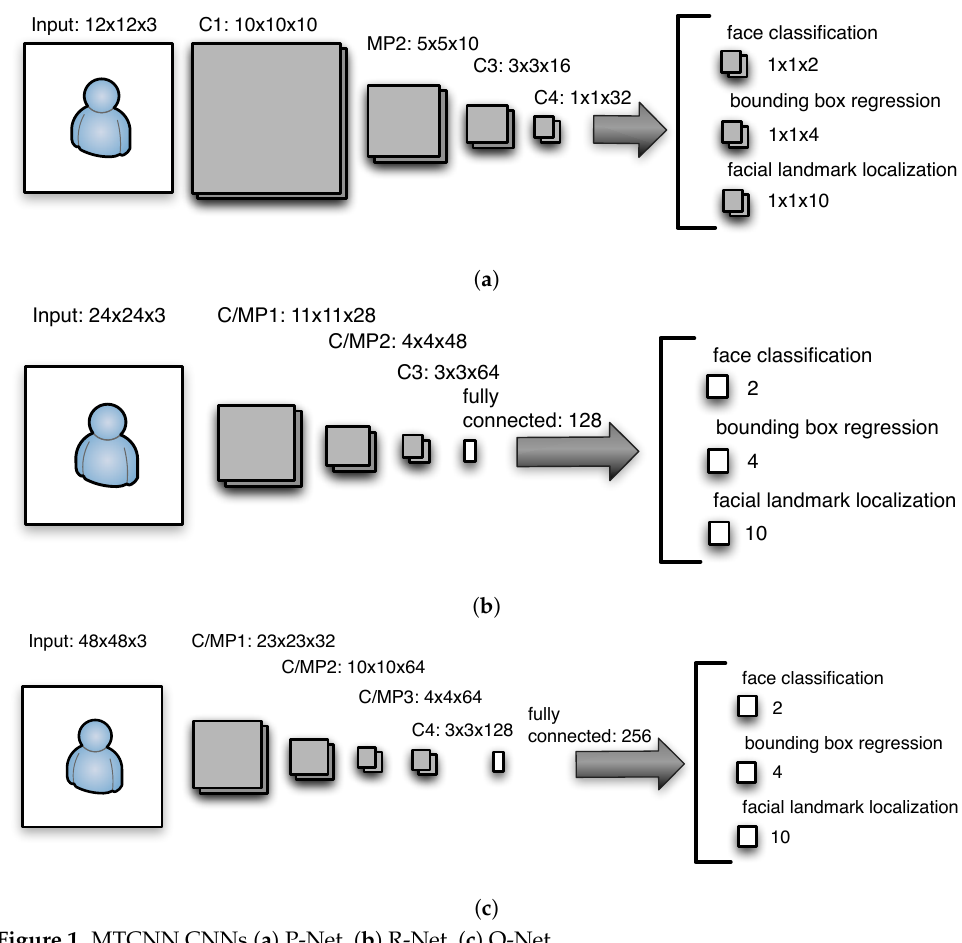
Figure 1. MTCNN CNNs ( a ) P-Net, ( b ) R-Net, ( c ) O-Net. Refine Network